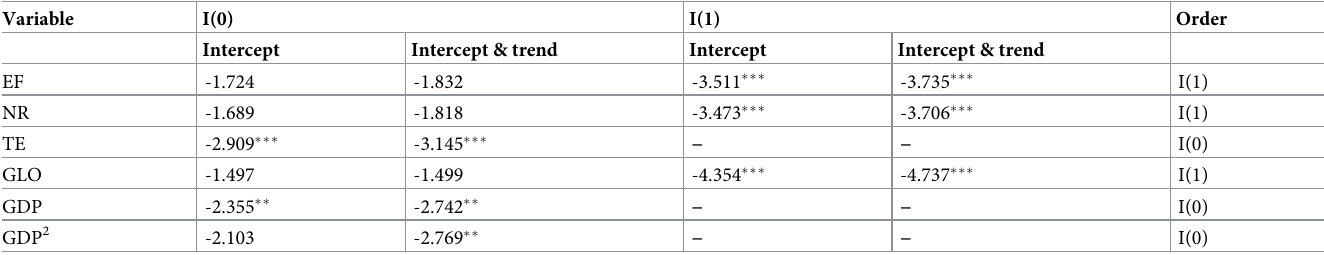
Table 3. CIPS panel unit root test